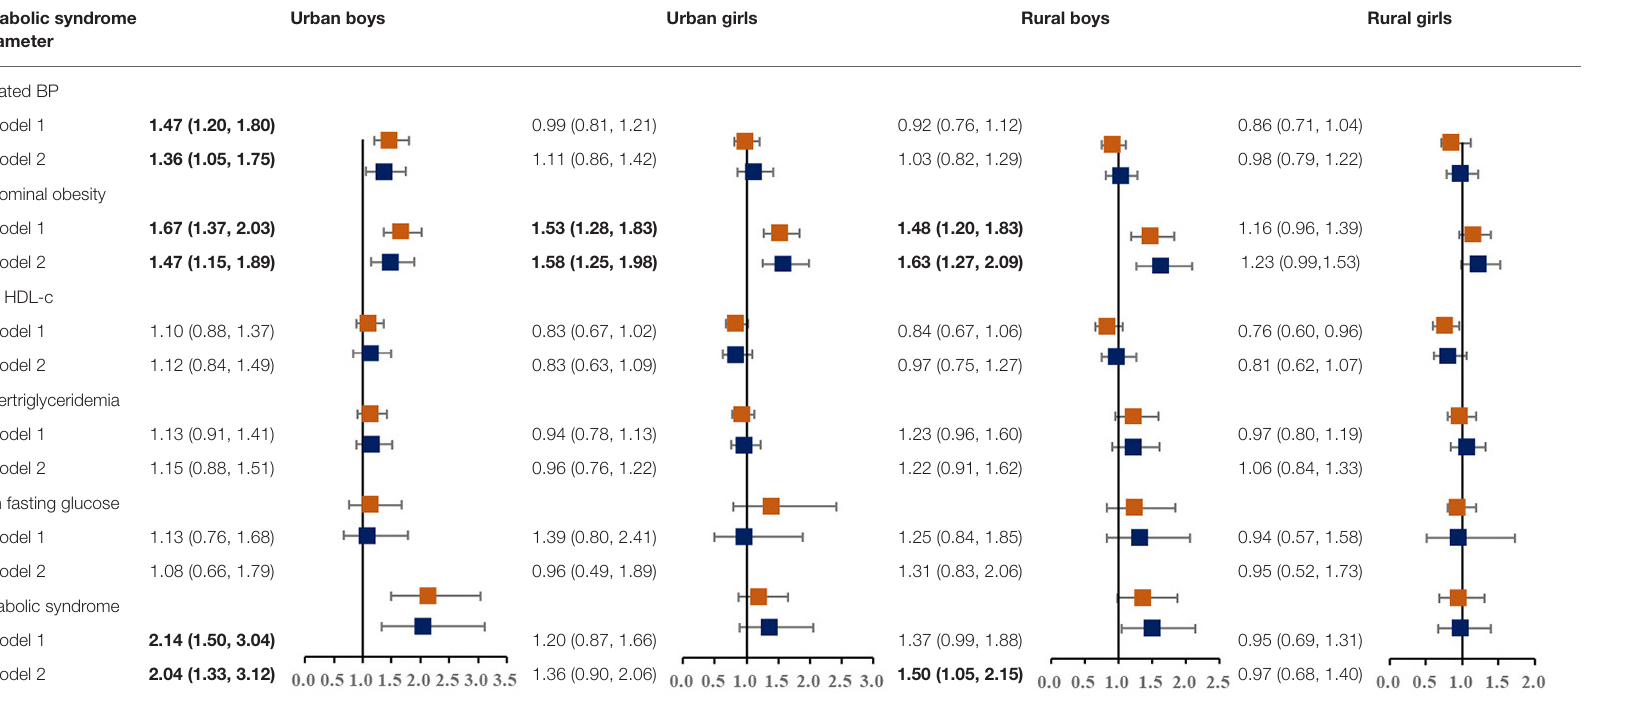
TABLE 4 | Multivariate odds ratios (OR) and 95% confidence intervals (CI) of metabolic syndrome according to single child status, stratified by residence-sex. Metabolic syndrome